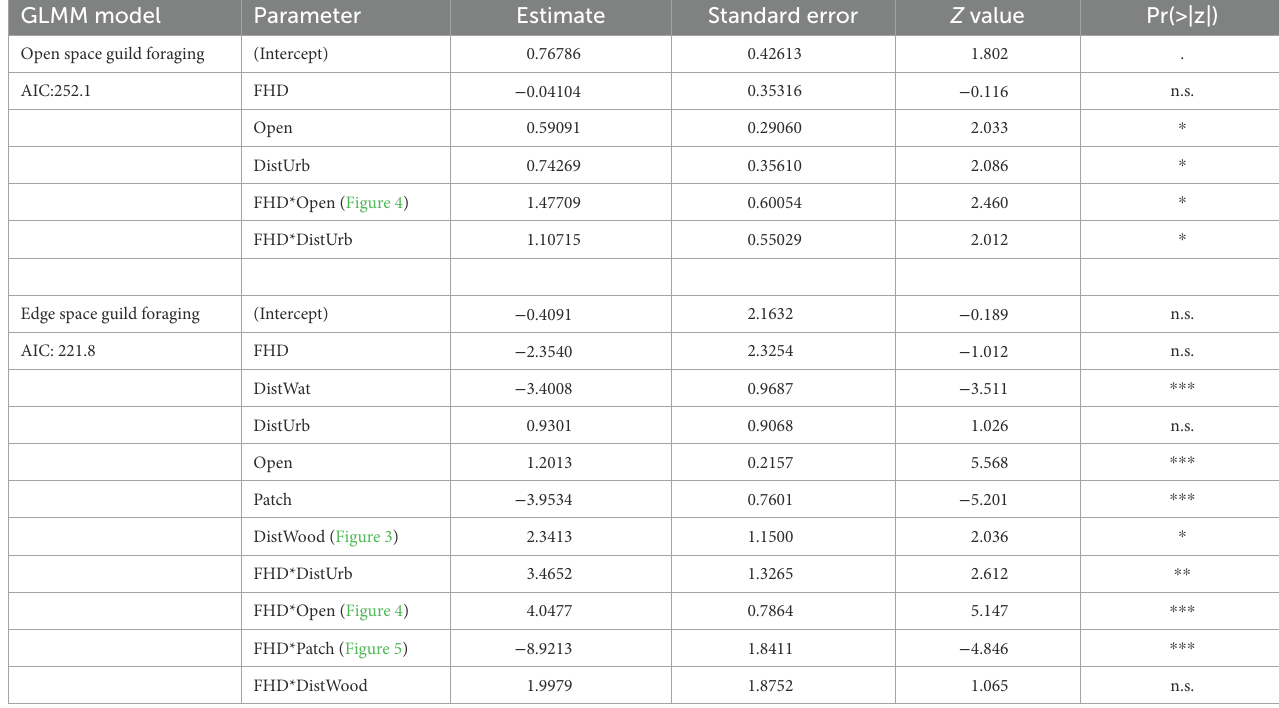
TABLE 4 Results of bat guild foraging activity predictions from the forward selections of generalized linear mixed models (GLMM) with negative binomial links based on selection of the best Akaike’s information criterion (AIC). GLMM